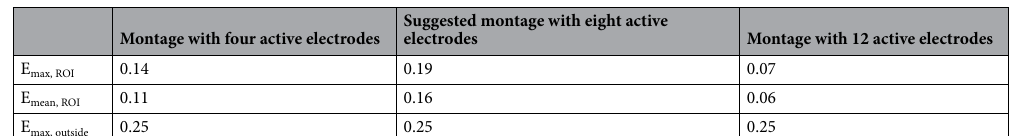
Suggested montage with eight active Montage with four active electrodes electrodes Montage with 12 active